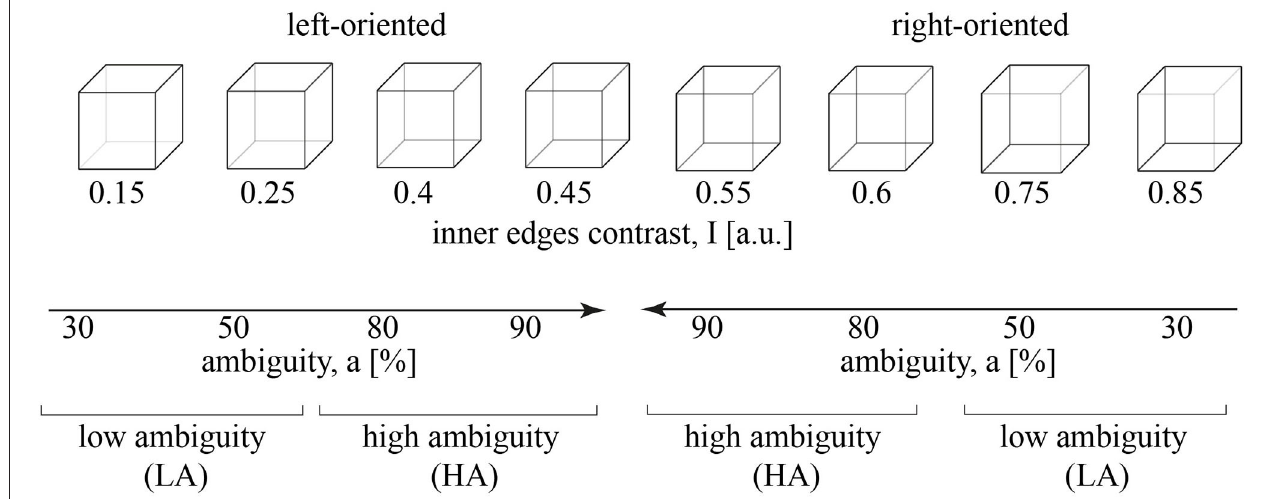
FIGURE 1 | A set of visual stimuli, Necker cubes, with the contrast of the inner edges, I . The stimuli with I = 0.15,0.25,0.4,0.45 are oriented to the left, while the stimuli with I = 0.55,0.6,0.75,0.85 are oriented to the right. The inner edges contrast defines a stimulus ambiguity, a that varies from 30 to 90 % . a = 30 % ,50 % corresponds to the low ambiguity (LA) and a = 80 % ,90 % - to the high ambiguity